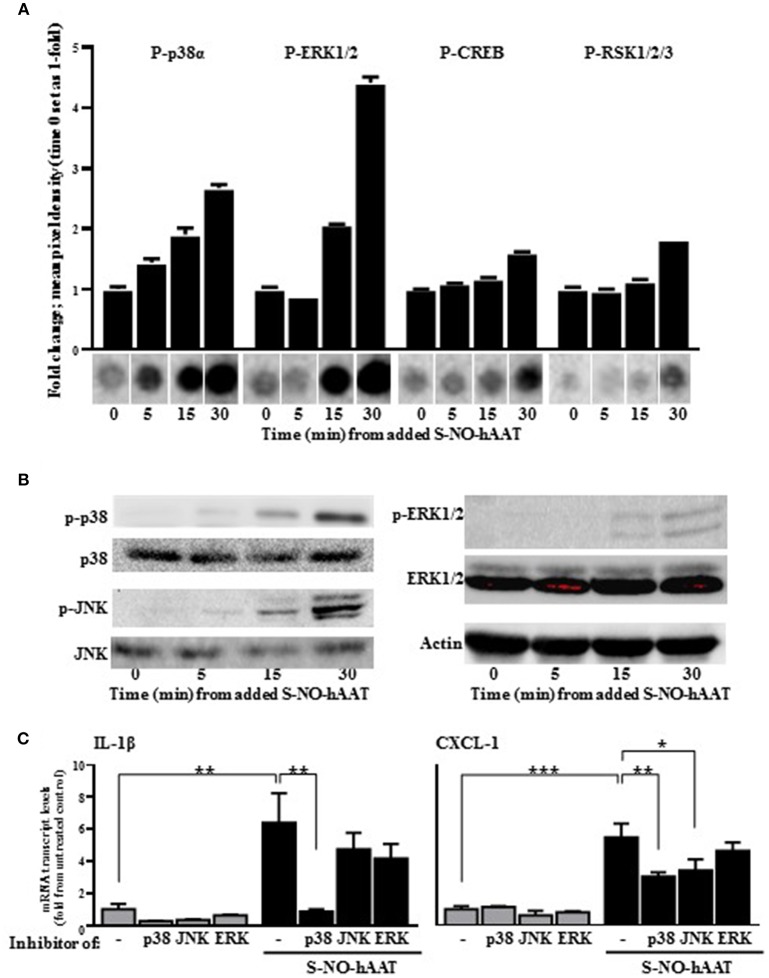
S-NO-hAAT activates MAPK signaling pathways. Peritoneal macrophages lysate (1 × 107 per well) after incubation with 27.5 μM S-NO-hAAT for indicated time periods. (A) Kinase array, performed once for each time interval. Graph, densitometry analysis, mean ± SD. Below, representative assay blots. (B) Representative Western blot analysis of MAPK signaling proteins. (C) mRNA transcript levels of IL-1β and CXCL-1 of naïve (gray) or 1 h S-NO-hAAT treated (black) peritoneal macrophages (0.25 × 106 per well) in the presence of signaling inhibitors or DMSO (–). mRNA transcript levels normalized to GAPDH (n = 3). Data are presented as mean ± SD. ns, non-significant, *p < 0.05, **p < 0.01, and ***p < 0.001.